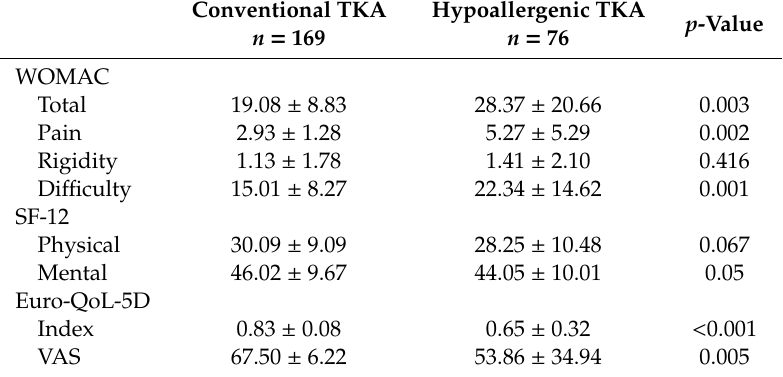
Table 5. Values of the propensity score matching (PSM) statistical analysis for the two study groups (conventional TKA versus hypoallergenic TKA) and the questionnaires (WOMAC, SF-12, and EuroQol-5D) after pairing the patients by age, sex, weight, previous psychiatric history and associated complications. The results are presented as the mean ± standard deviation